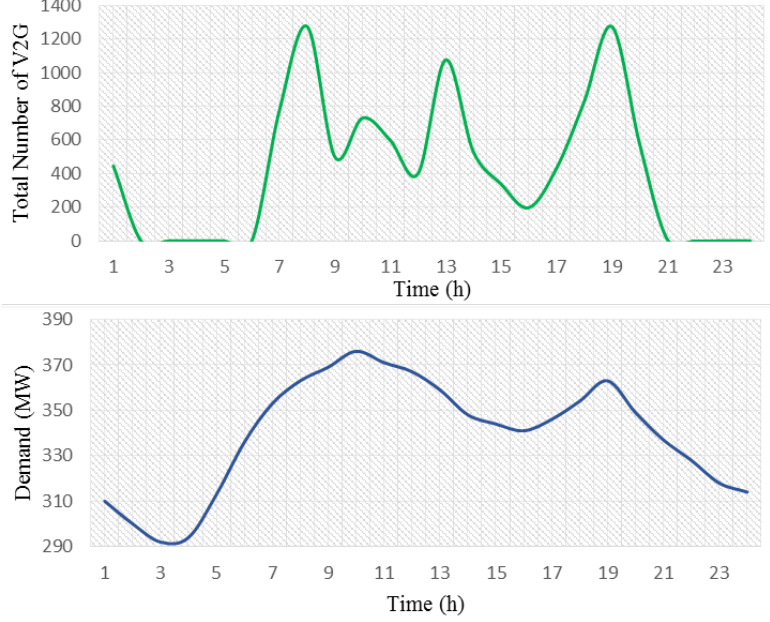
Figure 14. The number of connected electrical vehicles and the hourly load demand.